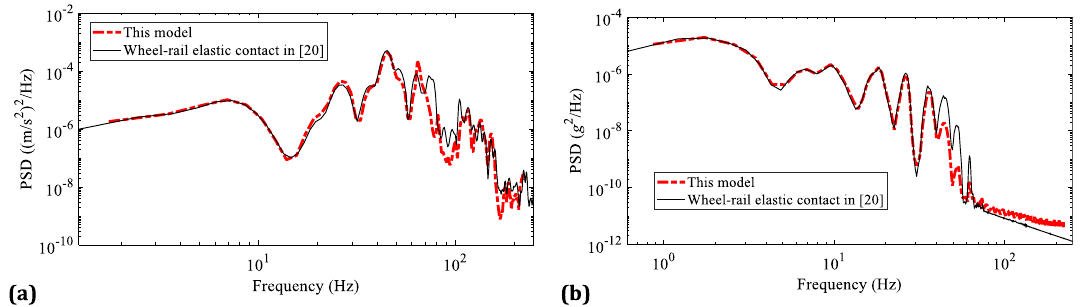
Fig. 10 Comparisons on the tunnel and car body vertical accelerations from frequency domain: a vertical acceleration of the tunnel segment under track structures; b car body vertical